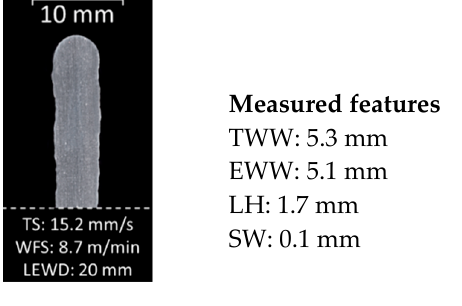
Figure 19. Typical cross-section of the preform deposited for experimental validation of the empirical modeling and optimization procedure and respective WAAM parameters (target wall width (T) of 5.0 mm).